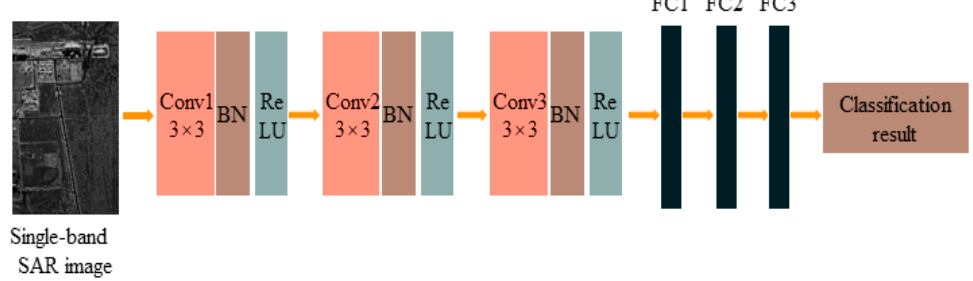
Figure 1. The network structure for single-band SAR classification.